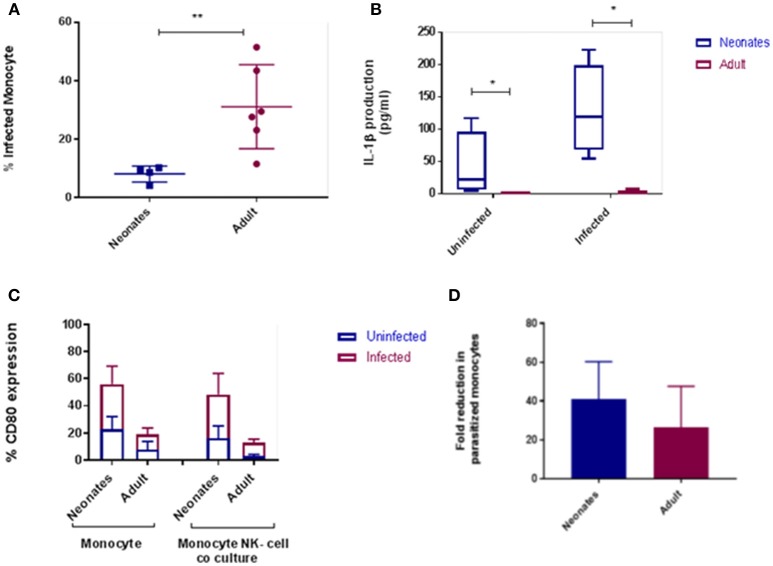
Cattle monocytes were infected with CFSE labeled N. caninum tachyzoites. (A) Parasite uptake was determined by flow cytometry 24 h post infection. These result shows significant difference between the percentage of infected neonates (N = 4) and adult (N = 6) CD14+ monocytes P-value < 0.01. (B) IL-1β production was in supernatants by ELISA after infection. The significance difference was noticed between neonate and adult infected and uninfected monocytes, P-value < 0.05. Data shows median with 95% confidence intervals, result were analyzed using Prism Graphpad 7.02 and statistical analysis was performed by using Mann Whitney test. (C) CD80 expression of monocyte and monocyte-NK cell co-cultured cells (10:1) from N. caninum infected and uninfected control samples after 24 h. Result were analyzed using GraphPad Prism 7.02 and statistical analysis was performed by 2 way ANOVA with Sidak's multiple comparison to determine the significance difference between neonates and adult. (D) Parasitized CD14+ monocytes co-cultured with autologous NK-cells were examined for parasite load after 24 h as above. Results, means plus 95% C.I., are presented as fold reduction compared with baseline parasite load pre-co-culture. *indicates a P-value < 0.05 and **indicates a P-value < 0.01.